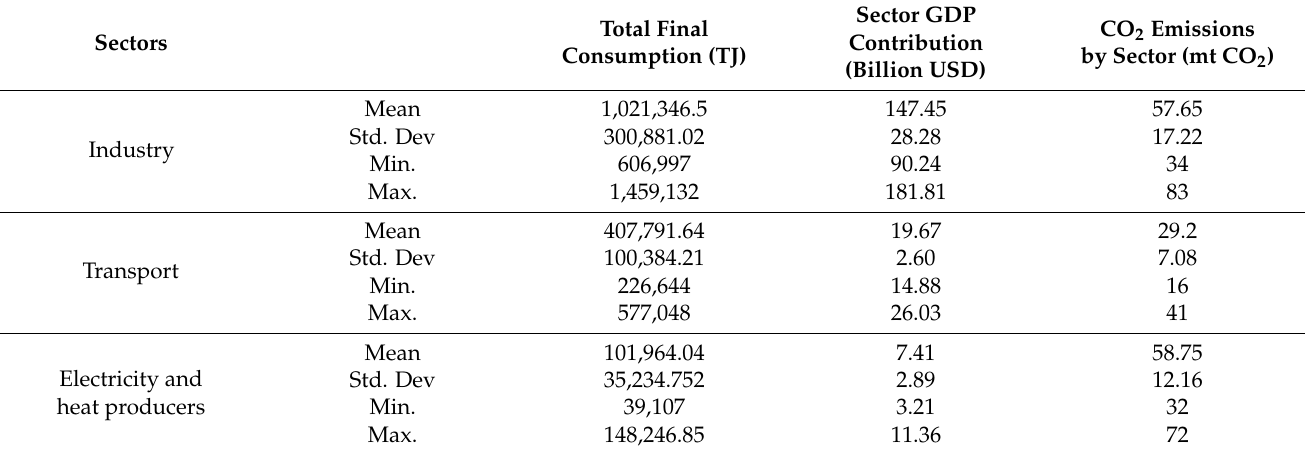
Table 1. Descriptive statistics for sector efficiency